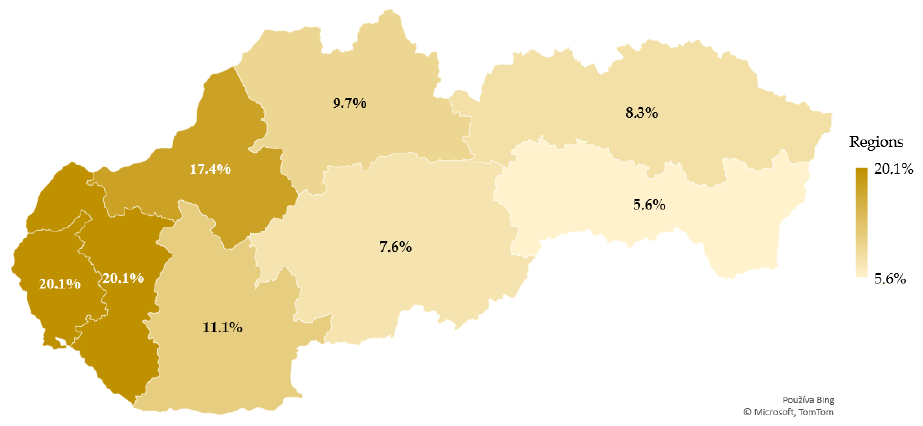
Figure 2. Data file structure by enterprise category. Source: Author ’ s own.